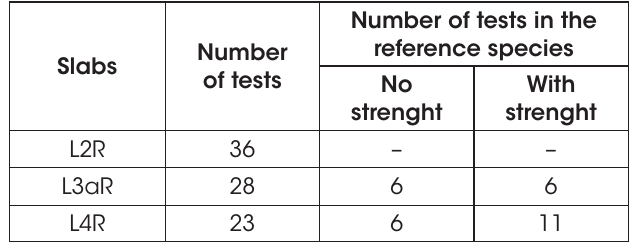
Number of pull-off tests